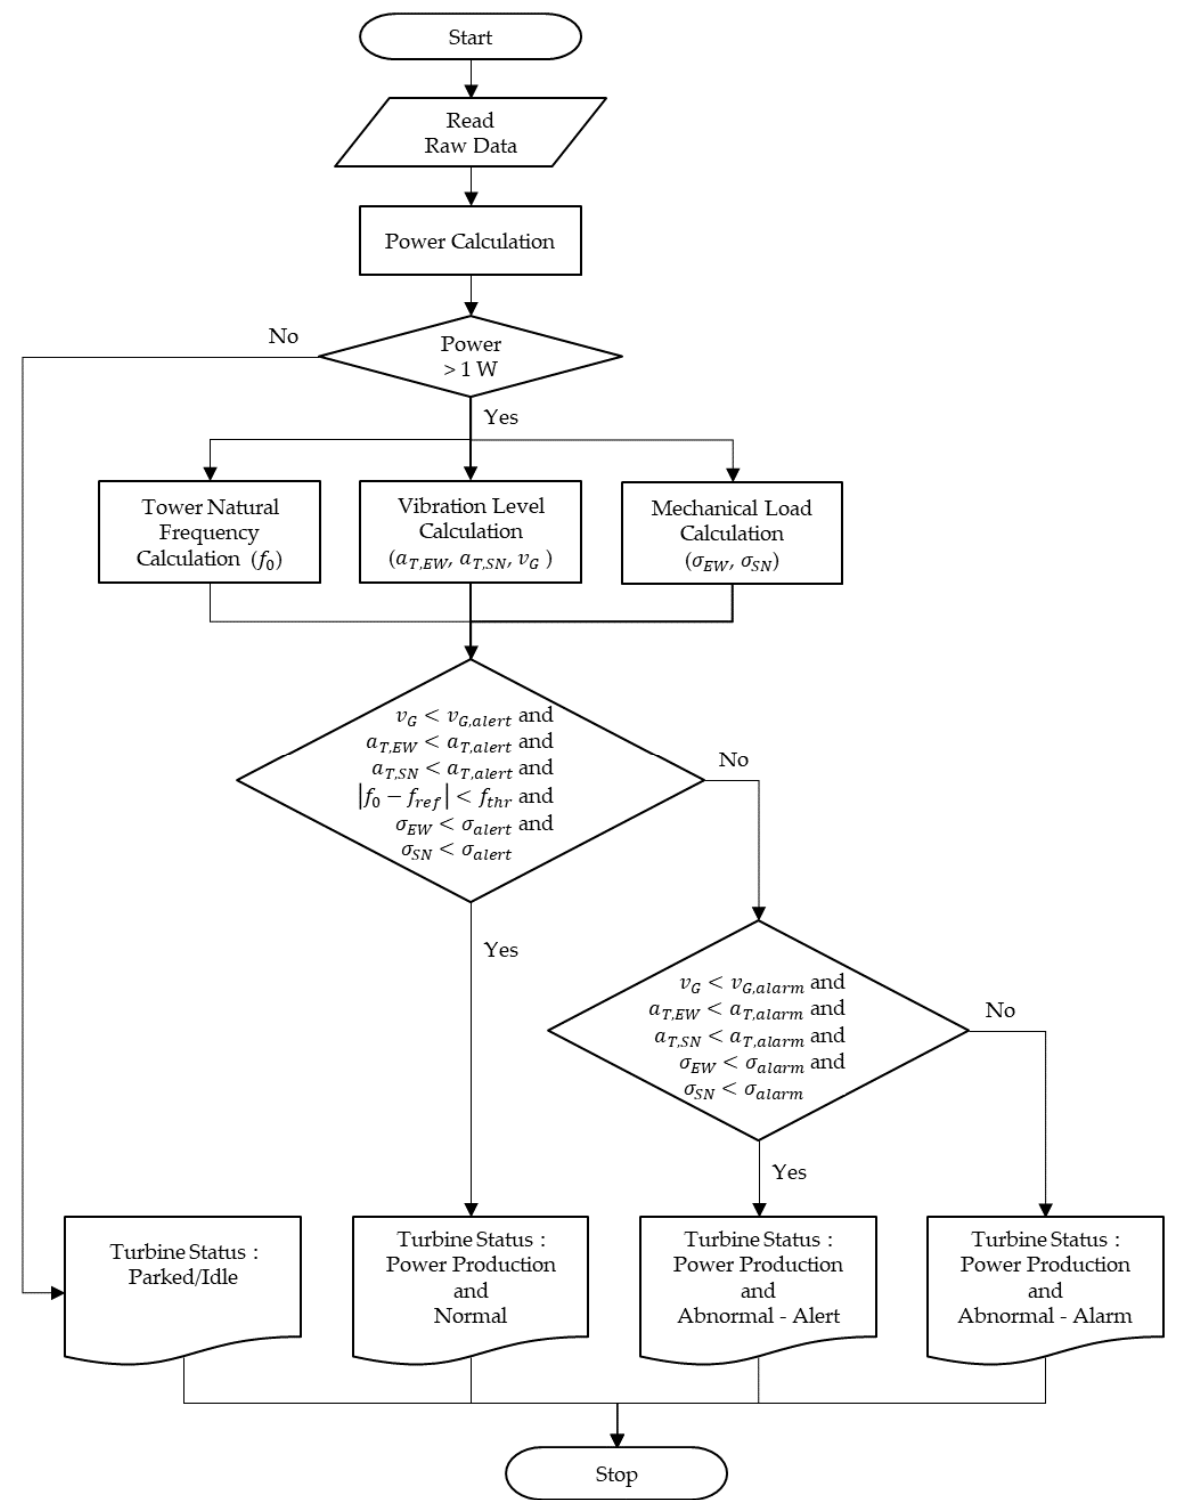
Figure 13. Flowchart of the main algorithm implemented for health monitoring and diagnosis.